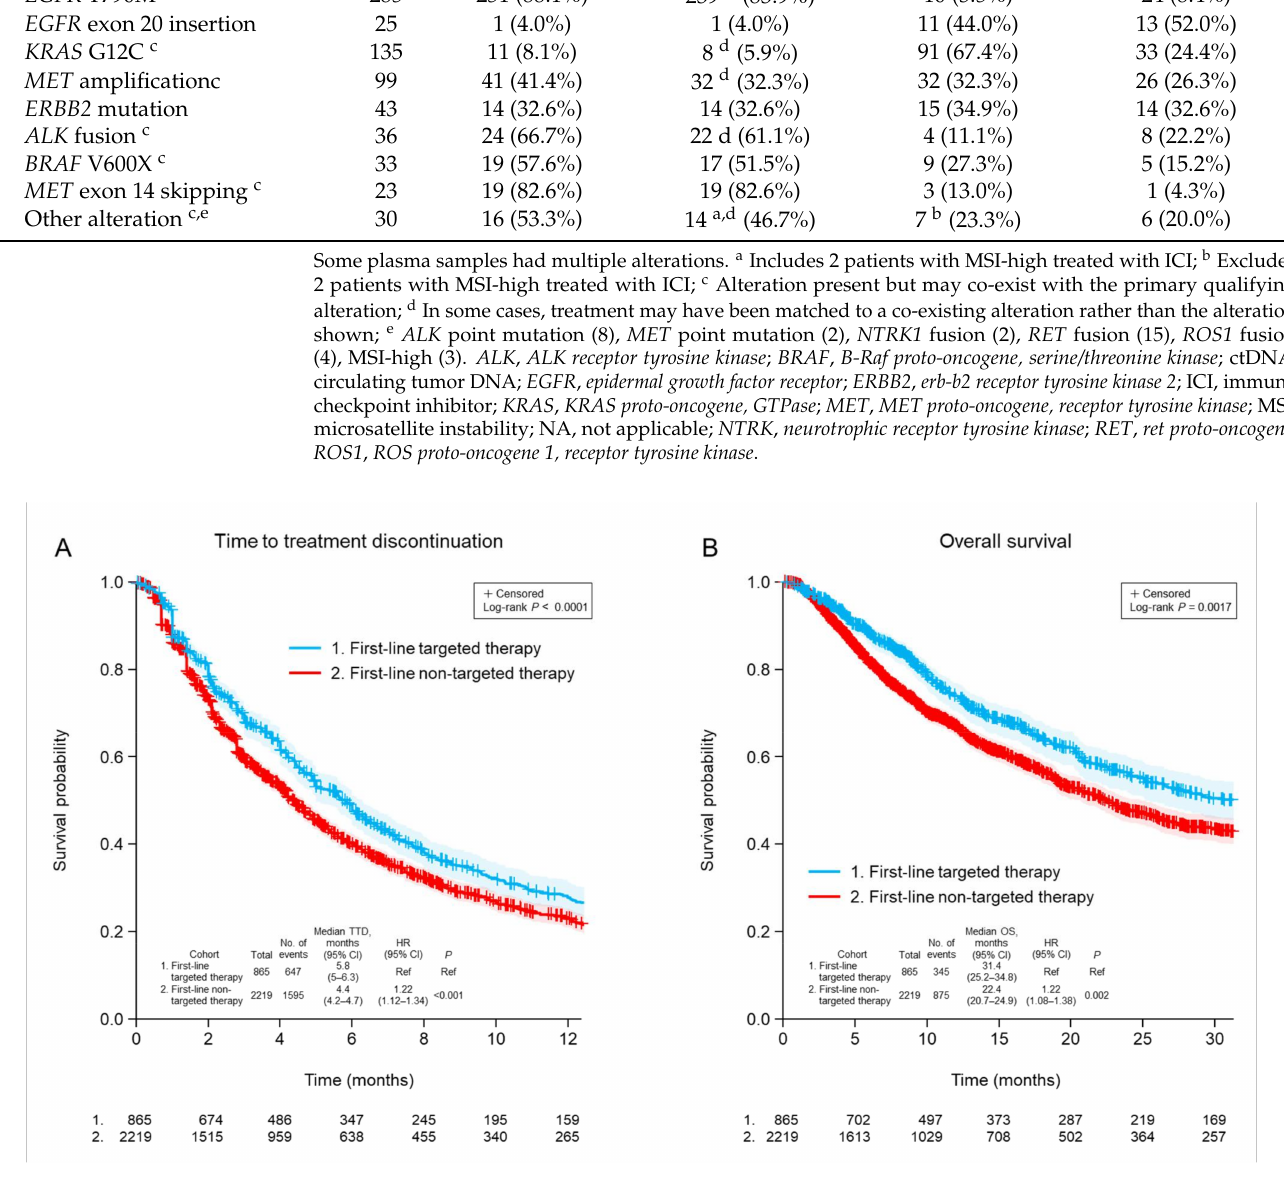
Figure 1. Time to discontinuation of second-line treatment ( A ) and overall survival ( B ) after ctDNA testing according to whether first-line treatment was targeted or non-targeted. CI, confidence interval; HR, hazard ratio; TTD, time to treatment discontinuation; OS, overall survival; Ref,